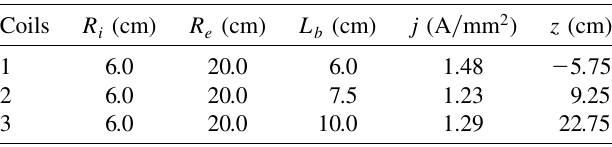
TABLE I. Magnetic coil system parameters.